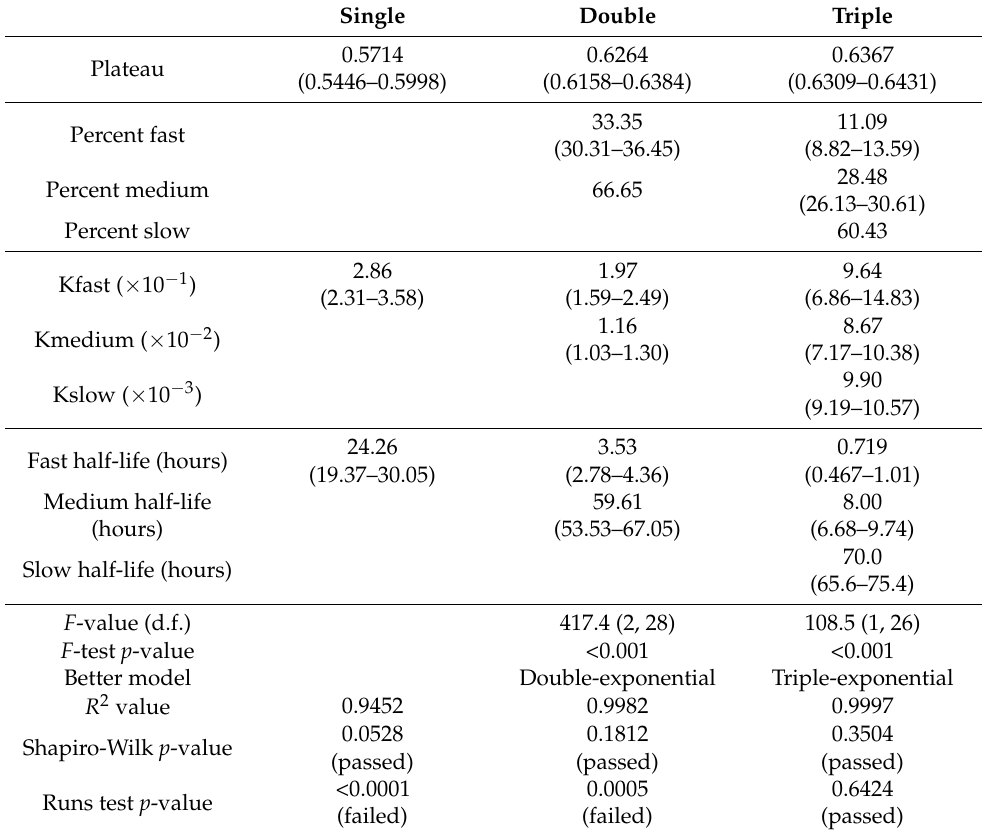
Table 1. Curve-fit parameters of single, double, and triple exponential models fitted to water uptake data for water control seeds in Figure 3. Numbers in parentheses represent the 95% confidence intervals of the estimates. An extra-sum-of-squares F-test was used to determine whether a more complex model fit the data significantly better than the immediately simpler